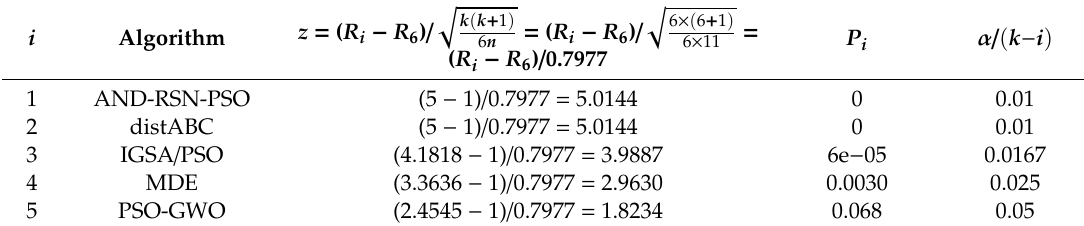
Table 13. The results of the Holm test.